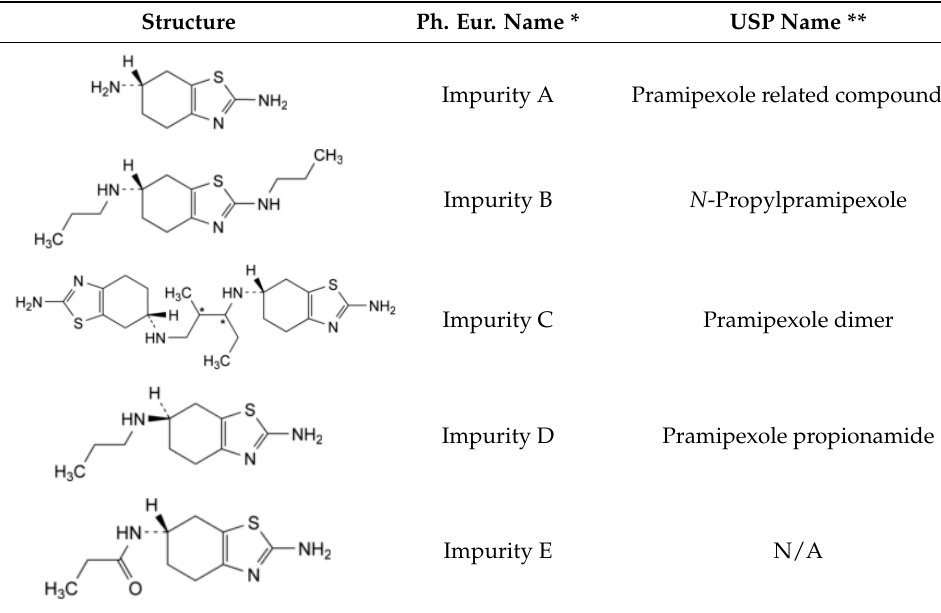
Table 1. Structures of pharmacopeial pramipexole related compounds.